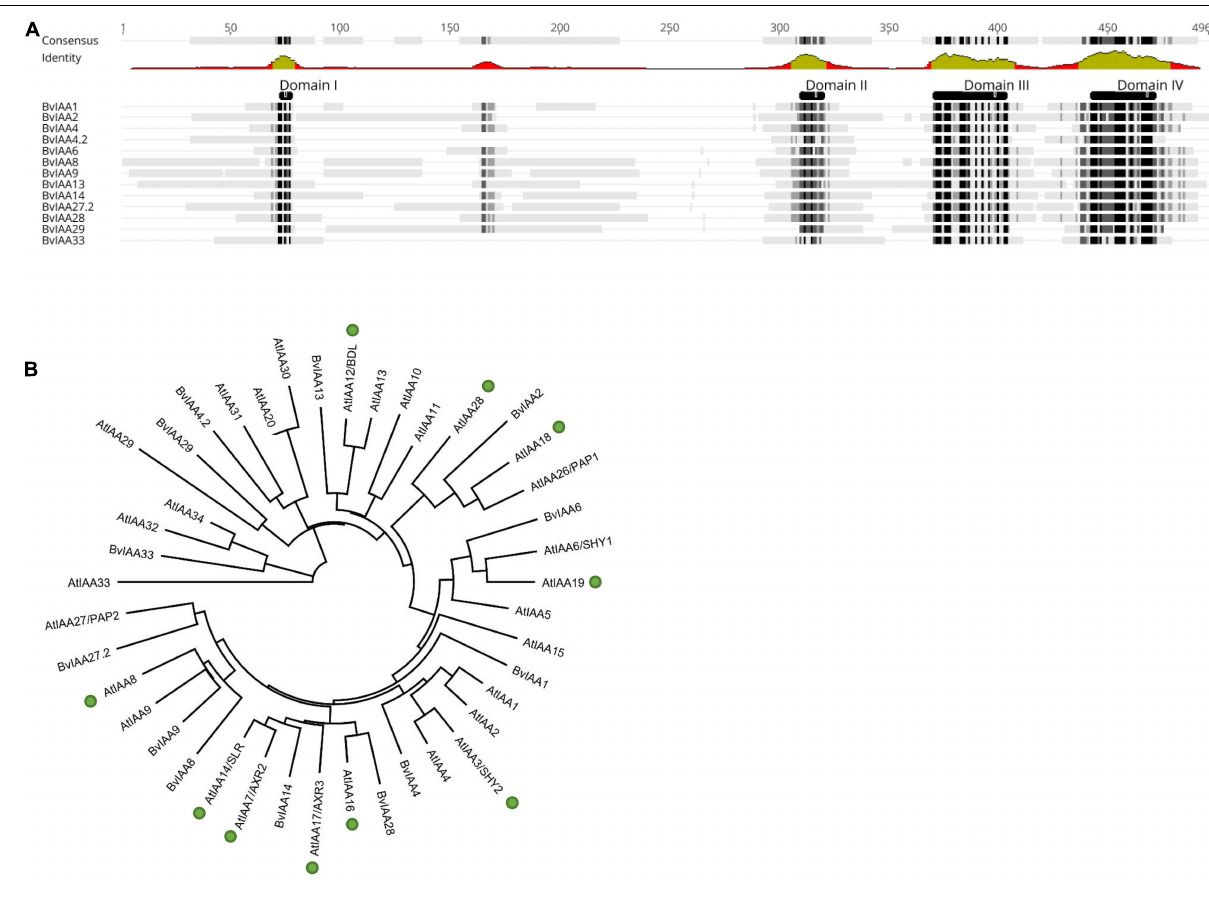
FIGURE 1 | (A) Multiple sequence alignment (Geneious 2020.1 software) of all IAA proteins from sugar beet (BvIAA). Black and gray shades in the sequences and green regions of graph below the consensus indicate a high homology of the protein sequences. The functional domains of the proteins are also shown above the sequences (DI-DIV). (B) Maximum likelihood tree of all BvIAA proteins and all Aux/IAA proteins from A. thaliana (AtIAA). Proteins involved in root formation in A. thaliana are highlighted with green circles (after Reed, 2001; Luo et al.,